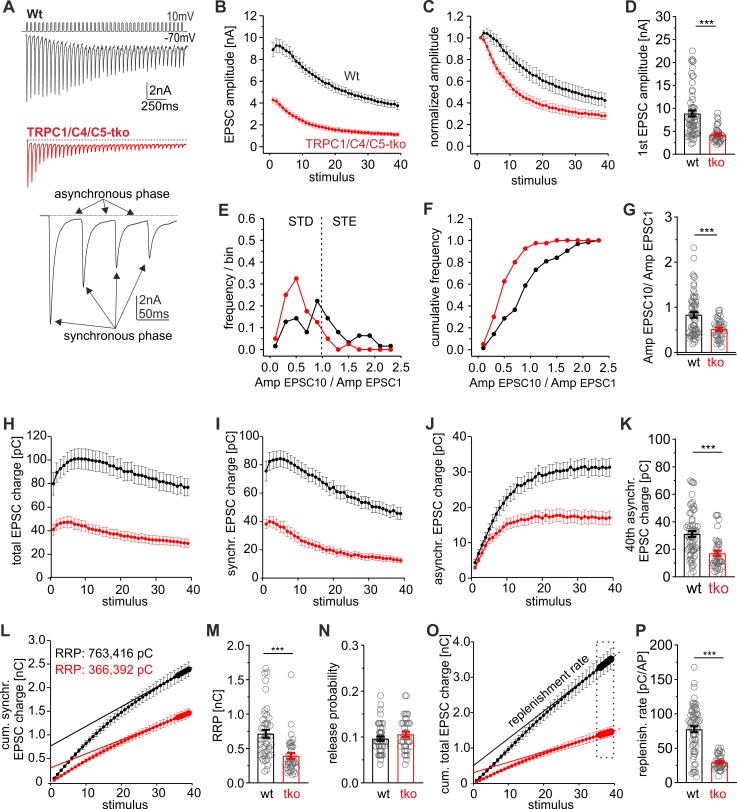
TRPC channels modulate the vesicle replenishment rate and the RRP size.(A) Exemplary EPSCs triggered by HFS (20 Hz, 40 AP/2 s) of autaptic wt and TRPC1/C4/C5 tko neurons (inset magnified view on the first 4 EPSCs of the train response. Arrows depict the synchronous and asynchronous phase of secretion). (B and C) TRPC deficiency reduces the EPSC amplitudes and accelerates the time course of synaptic depression (In panel C, data were normalized to the first EPSC amplitude). (D) The first EPSC amplitude is significantly reduced in tko cells (wt, n = 63; tko, n = 39 cells; p = 1.9 × 10−9). (E and F) The AmpEPSC10/AmpEPSC1 ratios of wt neurons range from STD to STE. Loss of TRPCs shifts the AmpEPSC10/AmpEPSC1 ratio towards STD. (G) The AmpEPSC10/AmpEPSC1 ratio is reduced in tko cells (p = 0.00067). (H, I, and J) The total synchronous and asynchronous charges are smaller in tko cells (red) when compared with controls (black). (K) Quantification of the 40th asynchronous charge (p = 0.0000056). (L) Mean cumulative synchronous release components during the 20-Hz train. Continuous line, linear regression of the last 5 data points back-extrapolated to stimulus = 0 to estimate the initial RRP size. Note that the RRP analysis was confined to wt neurons that reached a steady-state response in the late phase of stimulus train (45 out of 63 neurons). (M) The RRP size is significantly decreased in tko cells (wt, n = 45; tko, n = 39; p = 0.0000013). N. The release probability remained unchanged between groups (p = 0.2). (O) Cumulative total charge during 20-Hz train stimulation. The slope of the linear regression from the last 4 stimulation points (continuous line) rendered an estimate of the replenishment rate in panel P. (P) The replenishment rate is significantly reduced in tko neurons (p = 1.6 × 10−10). **p < 0.01; ***p < 0.001; statistical significance was assessed by Mann-Whitney rank sum test. Underlying data can be found in S1 Data. Amp, amplitude; AP, action potential; EPSC, evoked postsynaptic current; HFS, high-frequency stimulation; RRP, readily releasable pool; STD, short-term depression; STE, short-term enhancement; tko, triple knockout; TRPC, transient receptor potential canonical; wt, wild type.